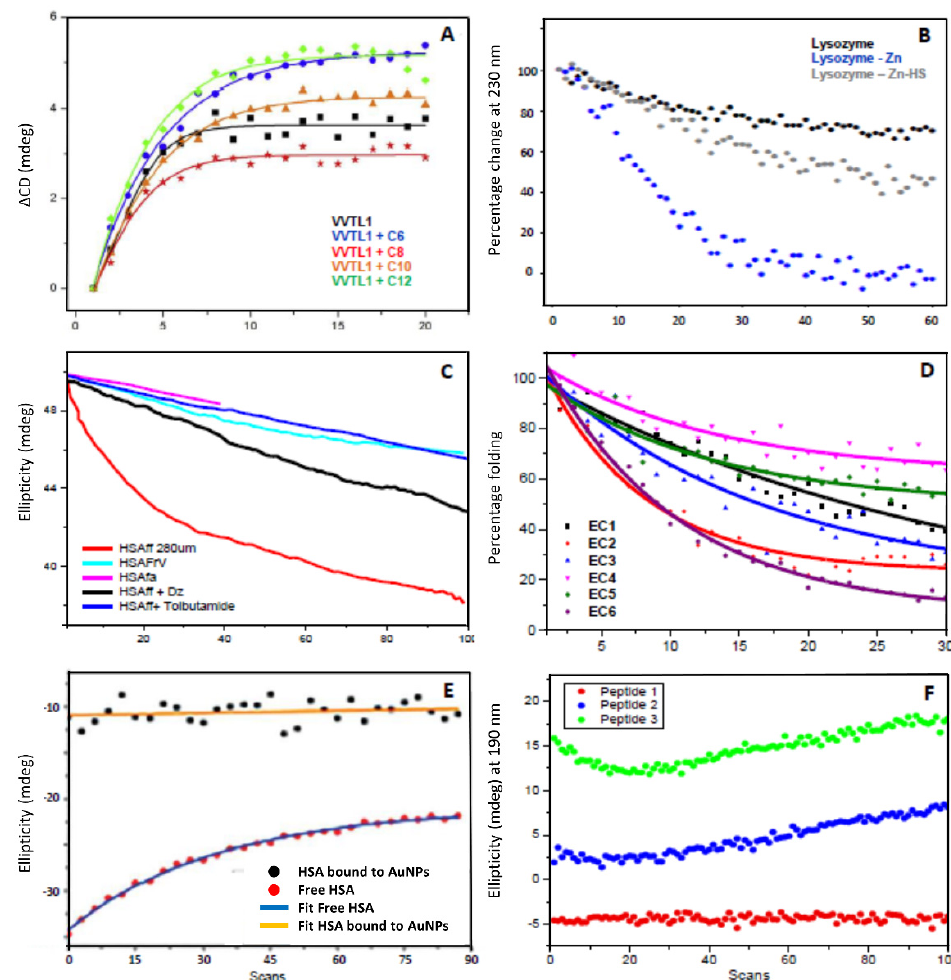
Figure 2. Examples of UV denaturation studies on different proteins. ( A ) Plot of SRCD intensity change ( ∆ CD) at 195 nm for Thaumatin-like protein VVTL1 in the presence of ethyl hexanoate (C6, blue), ethyl octanoate (C8, orange), ethyl decanoate (C10, red), and ethyl dodecanoate (C12, green) and absence of ethyl esters (black) calculated by subtracting the CD value of scan 1 from all the consecutive scans. Redrawn from [9]. ( B ) Plot of repeated consecutive SRCD signal at 230 nm for lysozyme with and without ligands showed conformational changes with different rates of protein denaturation. Redrawn from [14]. ( C ) Rate of UV protein unfolding (denaturation) of human serum albumin fatty acid free (HSAff) in H 2 O with and without ligands such as fatty acid (octanoic acid), diazepam, and tolbutamide plotted at 190 nm for 100 repeated consecutive SRCD spectra. Redrawn from [15]. ( D ) Rate of UV protein denaturation of antibody Mab-1 in different formulations assessed with 30 repeated consecutive SRCD spectra. Redrawn from [11]. The rates reported in percentage of protein folding were calculated by dividing the CD intensity at a fixed wavelength of the protein- ligand complex by that of the protein alone at the same concentration as that of the complex and multiplied by 100. ( E ) Plot of SRCD signal at 209 nm as a function of UV-exposure time that is equiv- alent to light irradiation when scanning repeated consecutive SRCD spectra for free human serum albumin HSA (red circles for experimental data and blue line for fitting) and for HSA bound to AuNP (black squares for experimental data and orange line for fitting). Redrawn from [16]. ( F ) Plot of repeated consecutive SRCD signal at 190 nm of three related vasoactive intestinal peptide (VIP) in MES buffer: a wild type (peptide 1, red), one mutated W25S (peptide 2, blue) and one mutated W25S with palmitoylated K20 (peptide 3, green). Redrawn from [11].